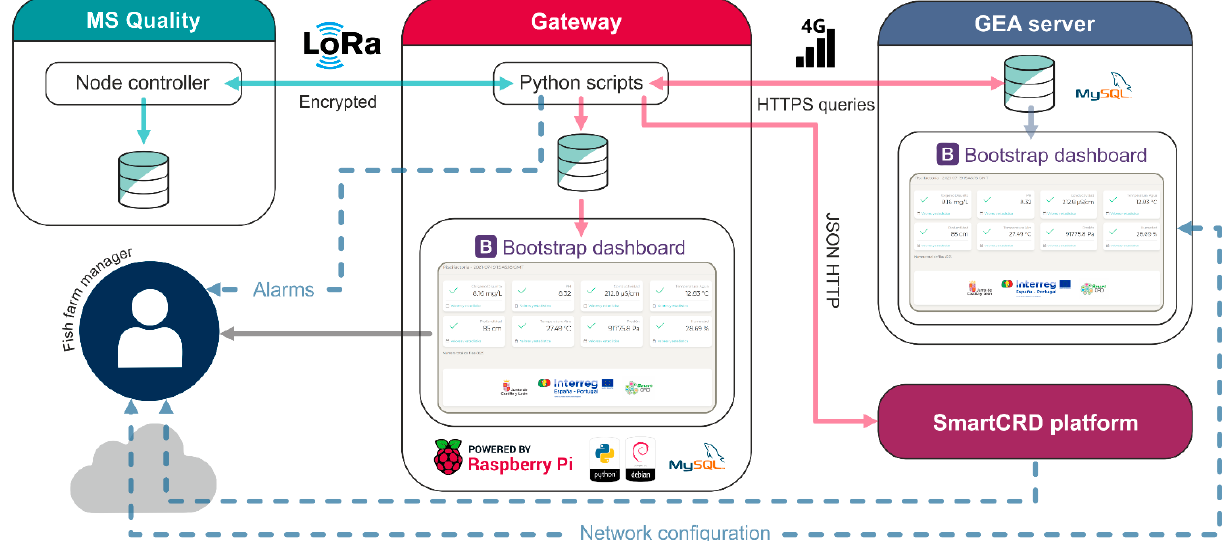
Figure 5. The general software and communication architecture of the sensor network.